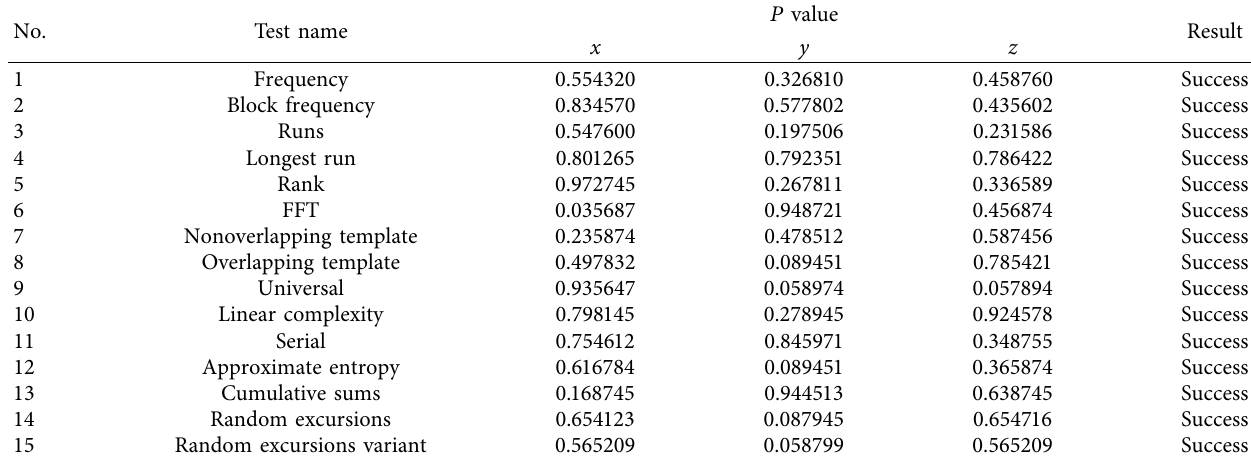
Table 1: The NIST test results of each component generated by